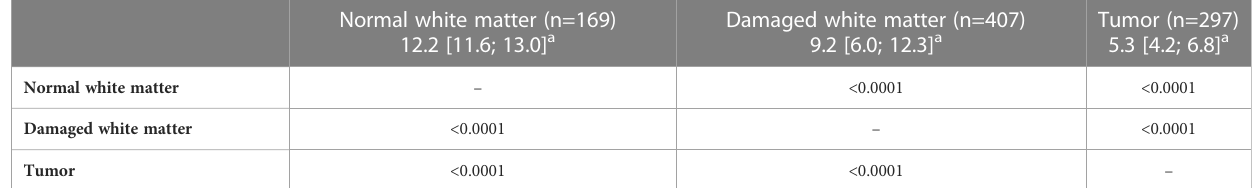
TABLE 3 Comparison of the studied tissue types using Att(cross) coef fi cient.